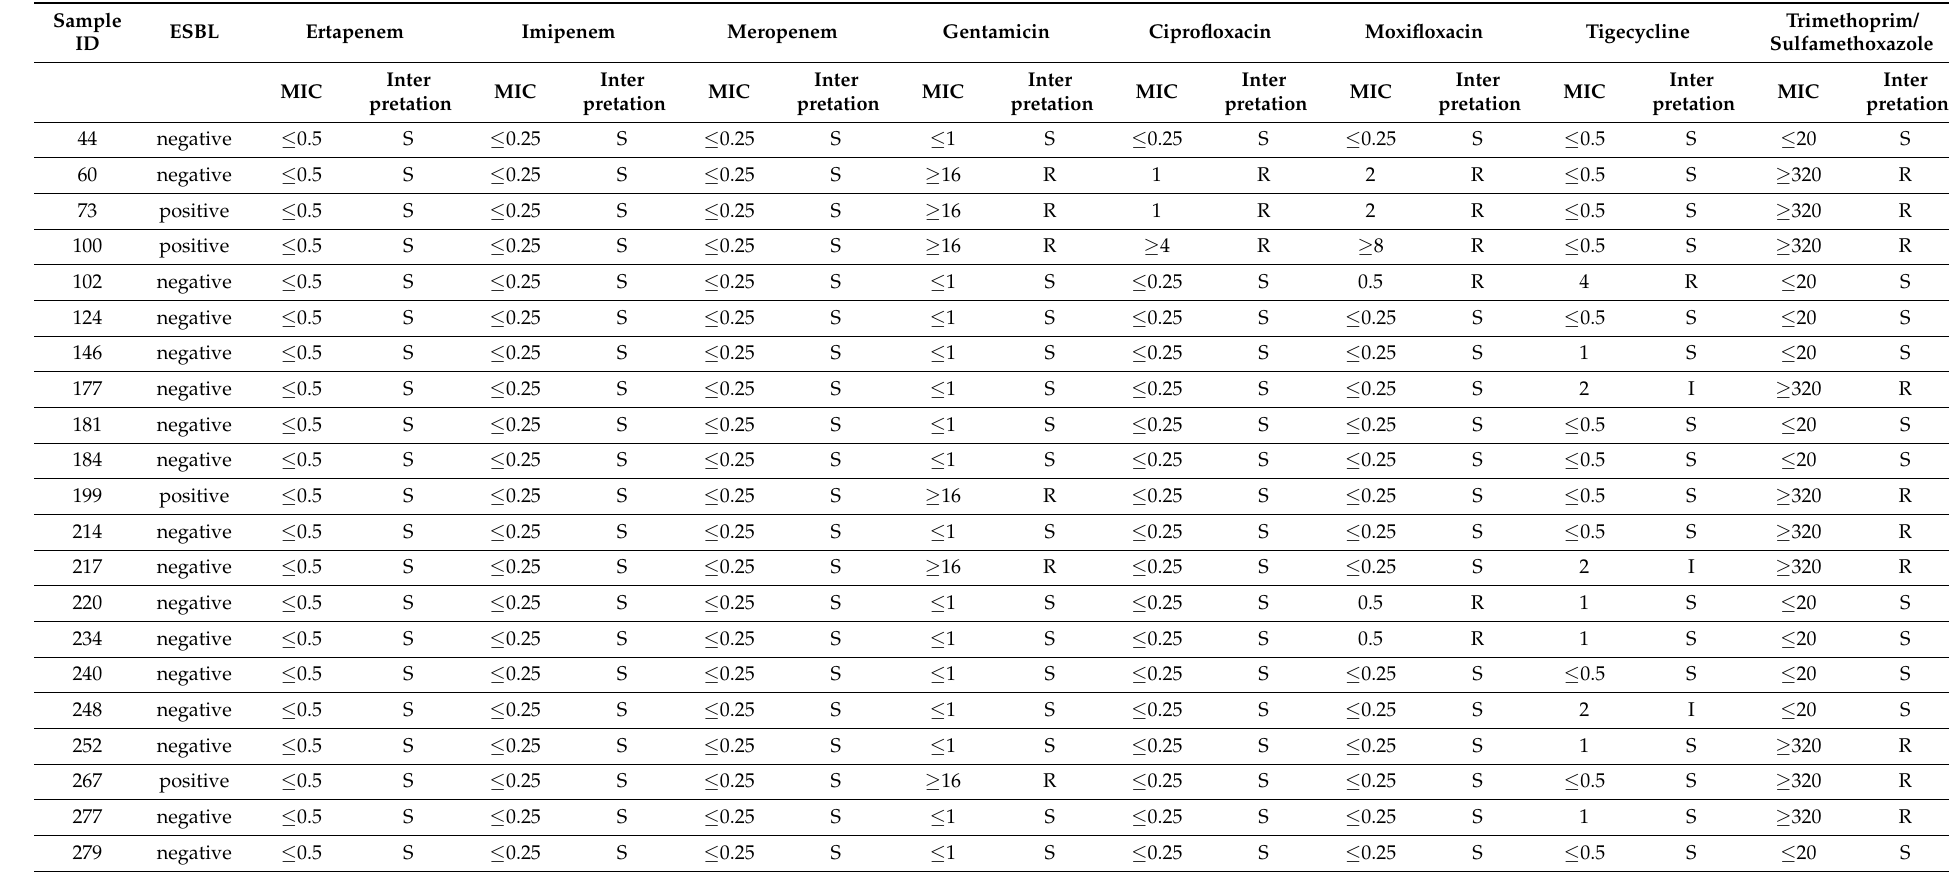
Table A6. Phenotypic resistance of the Klebsiella strains. MIC = minimum inhibitory concentration. ESBL = signal in phenotypic testing for extended-spectrum beta-lactamases. Sample